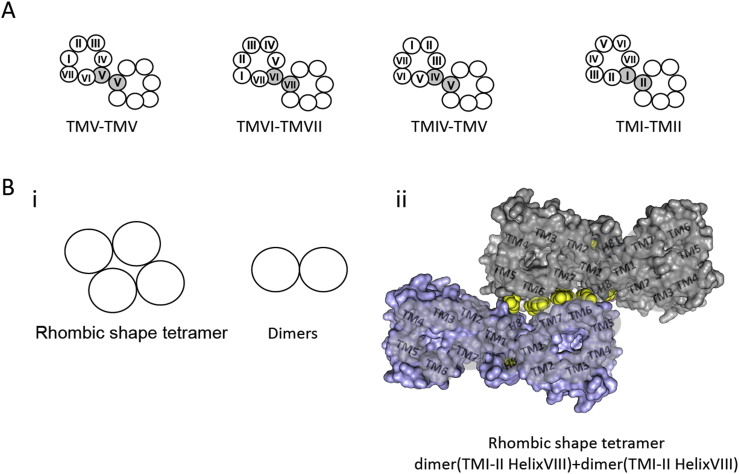
Quaternary organization of the hM3R. (A) Representation of the four distinct low energy M3R dimeric structures as described by McMillin et al., (2011). The transmembrane domains identified as being important for hM3R protomer-protomer interactions are shown in grey circles. (Bi) Schematic representation of the quaternary arrangements of M3R as described by Patowary et al., (2013). M3R can form rhombic-shaped tetramers and dimers that are in equilibrium at the cell membrane. (Bii) Molecular model of the M3R tetramer with a rhombic arrangement as a complex of two dimers represented as grey and blue surfaces. Predicted molecules of cholesterol are shown as yellow spheres (Figure adapted from Liste et al., 2015).